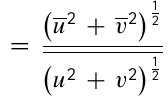
low values during winter ( < 1 g kg − 1 ) and for the max- imum values during summer ( ≈ 4 g kg − 1 ). years within the measurement period (bias = − 0.05 g kg − 1 ; RMSE = 0.26 g kg − 1